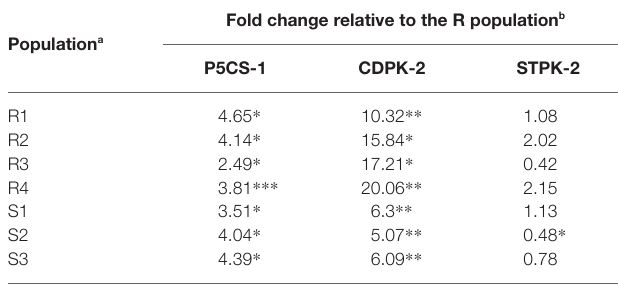
TABLE 3 | The expression levels of stress response genes in seven different